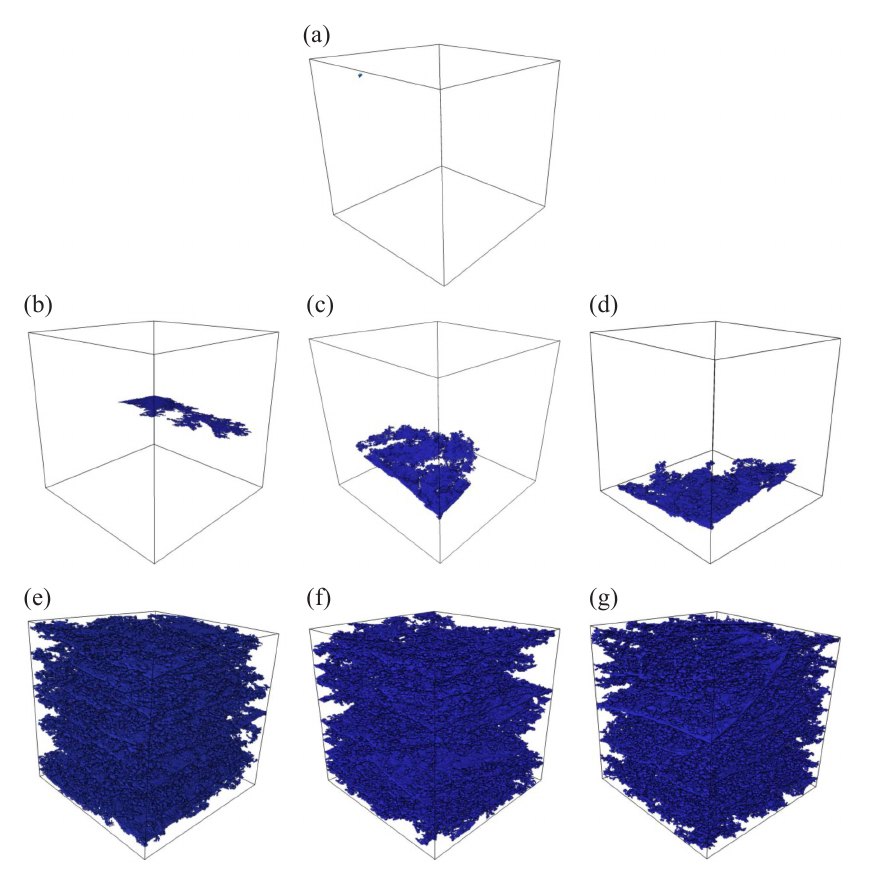
Fig. 7. Maximum pore group distribution of oil shale at different temperatures: (a) original sample (25 °C); (b) 300 °C; (c) 350 °C; (d) 400 °C; (e) 450 °C; (f) 500 °C; (g) 550